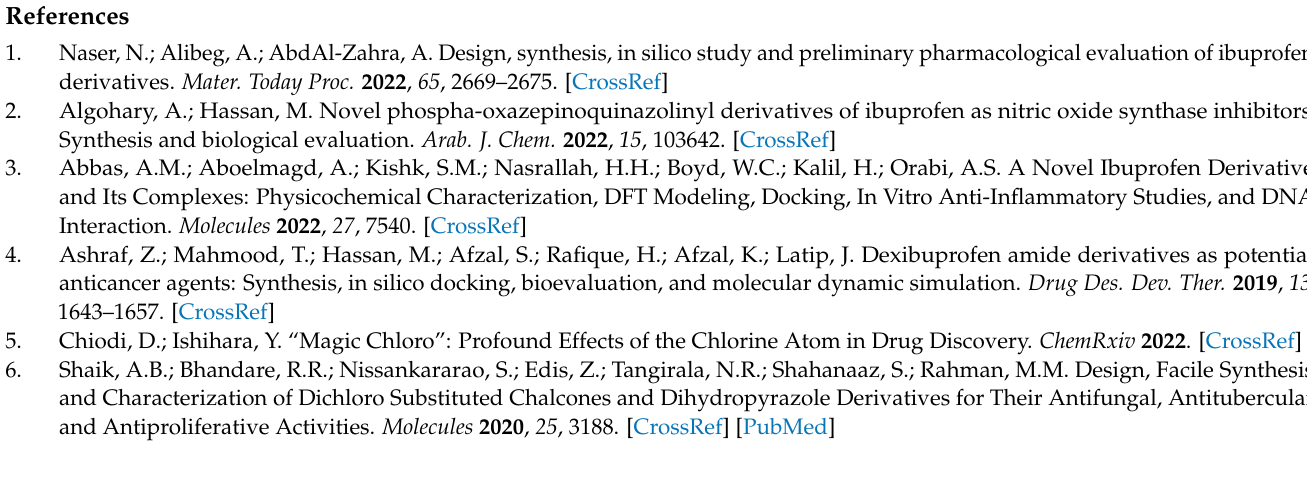
Supplementary Materials: Thefollowing supportinginformationcan bedownloadedonline. Figure S1.1: 1 H-NMR spectrum of compound 3 ; Figure S1.2 Region 1.5–3.5 ppm from the 1 H-NMR spectrum of compound 3 ; Figure S1.3: Aromatic region of the 1 H-NMR spectrum of compound 3 ; Figure S2: 13 C-NMR spectrum of compound 3 ; Figure S3: UV spectrum of compound 3 ; Figure S4: ESI-HRMS of compound 3 ; Figure S5: IR spectrum of compound 3